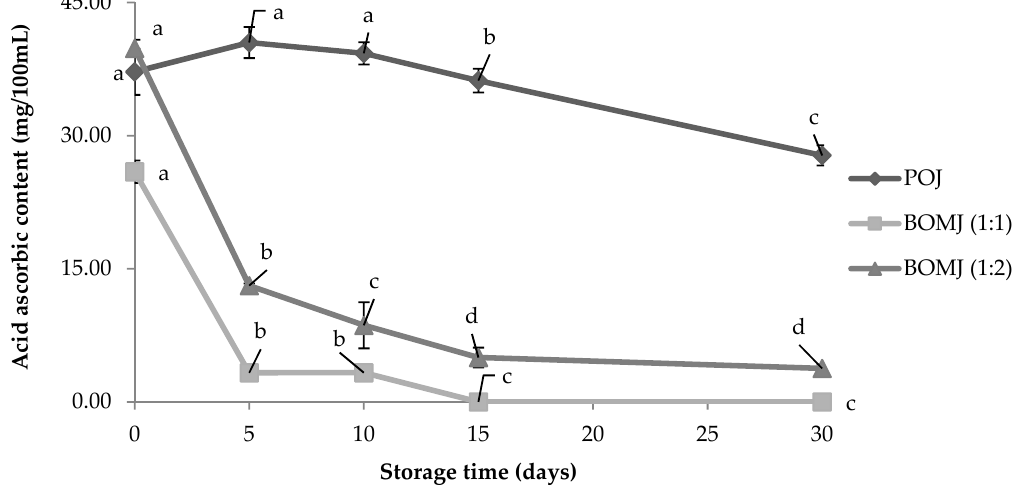
Figure 2. Acid Ascorbic Content (mg/100mL) in juices stored at 4 °C for 30 days. The values represent the mean ± standard deviation ( n = 9). Different superscript lower case letters indicate significant difference ( p < 0.05) for each juice in relation to storage time. POJ, pasteurized orange juice; BOMJ 1:1, pasteurized beet and orange mix juice 1:1 (v/v); BOMJ 1:2, pasteurized beet and orange mix juice 1:2 (v/v).